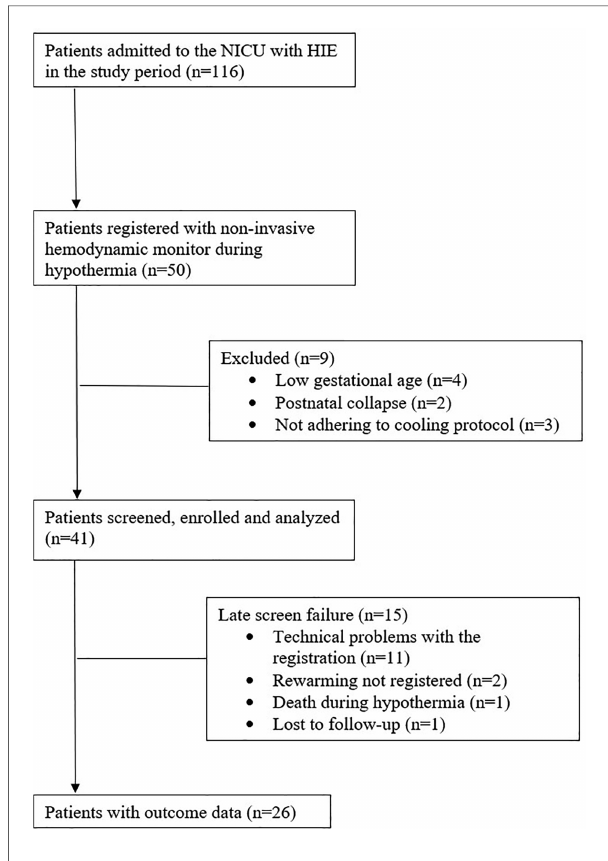
FIGURE 1 Flowchart showing the enrollment procedure of the